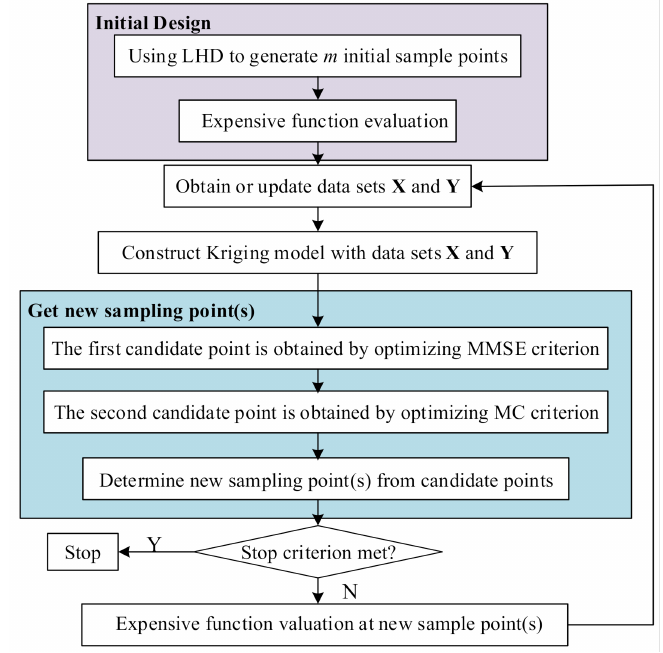
Figure 3. The flowchart of the HKM-HS method.